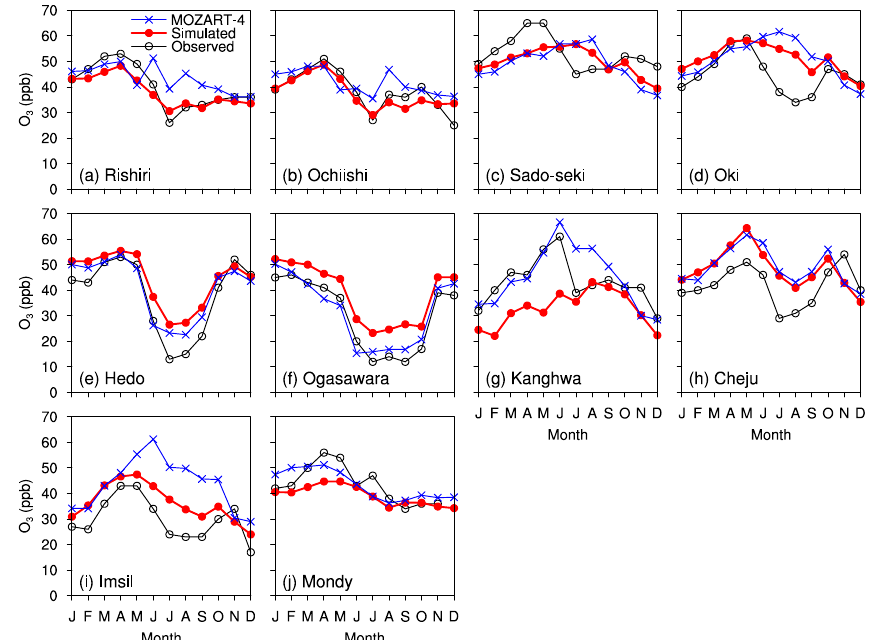
Figure 3. Monthly mean observed and simulated surface ozone concentration in BASE for 2010 at 10 EANET monitoring sites. Results of MOZART-4 are also shown.